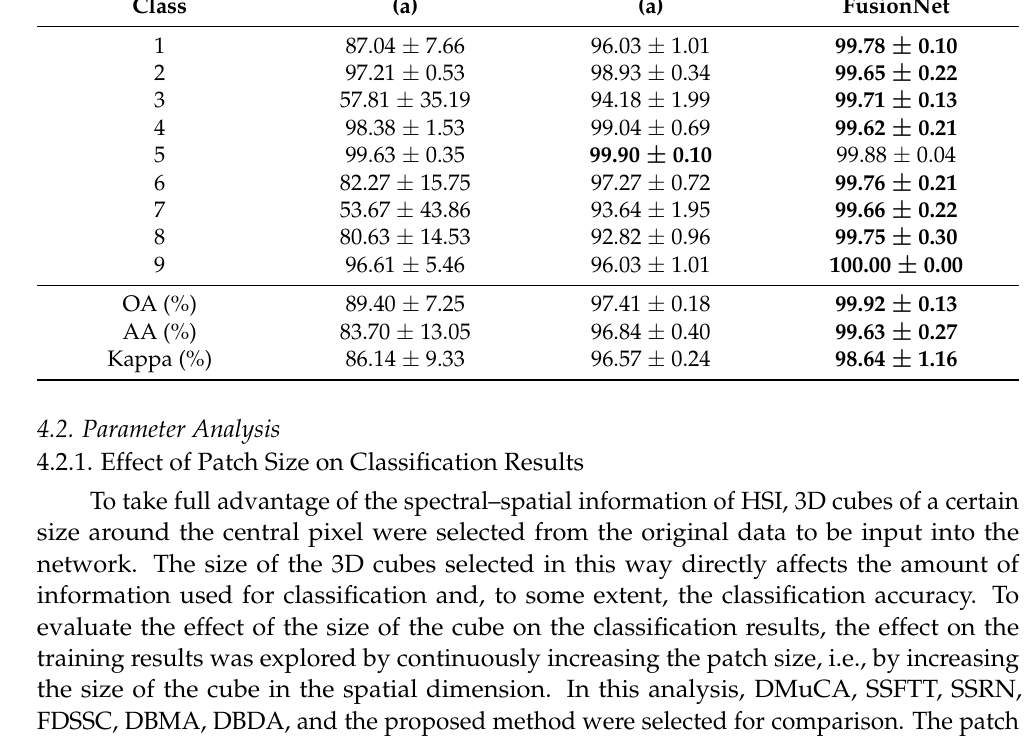
Table 9. Comparison results of (a), (b), and the original FusionNet on the Pavia University dataset.